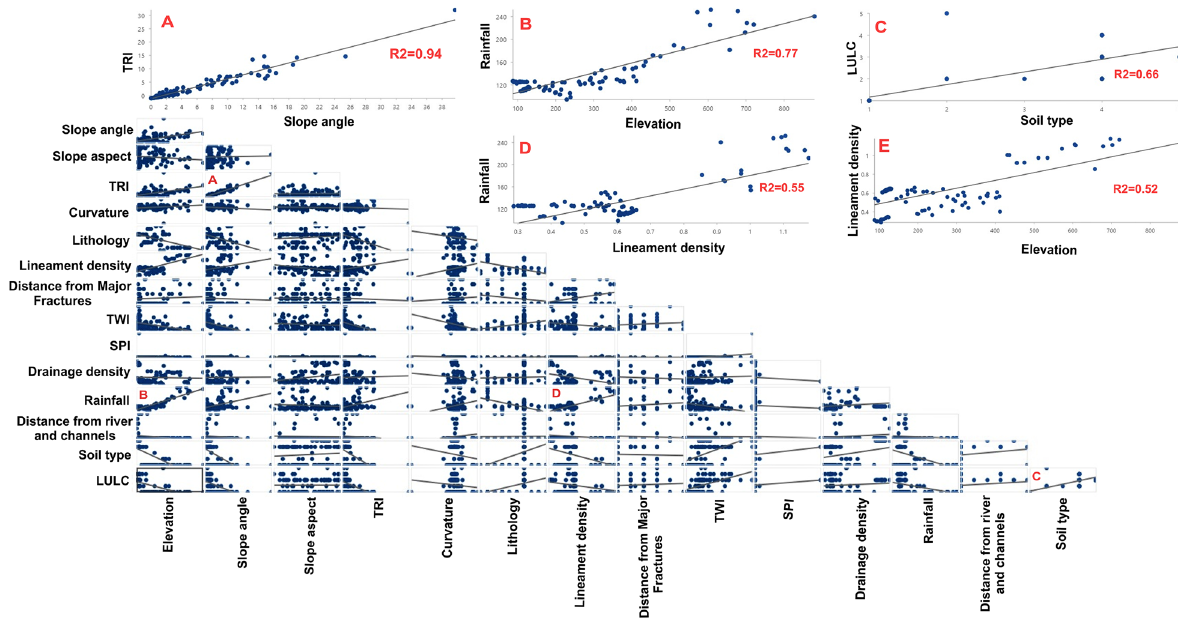
Fig. 6 Pairwise linear relationships associated with R-squared for all effective features